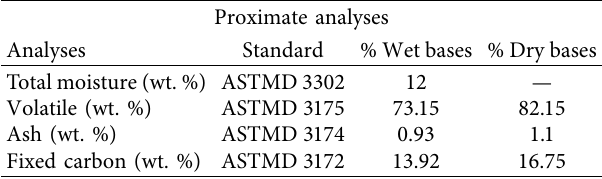
Table 2: The proximate analysis obtained from laboratory. Proximate analyses Analyses